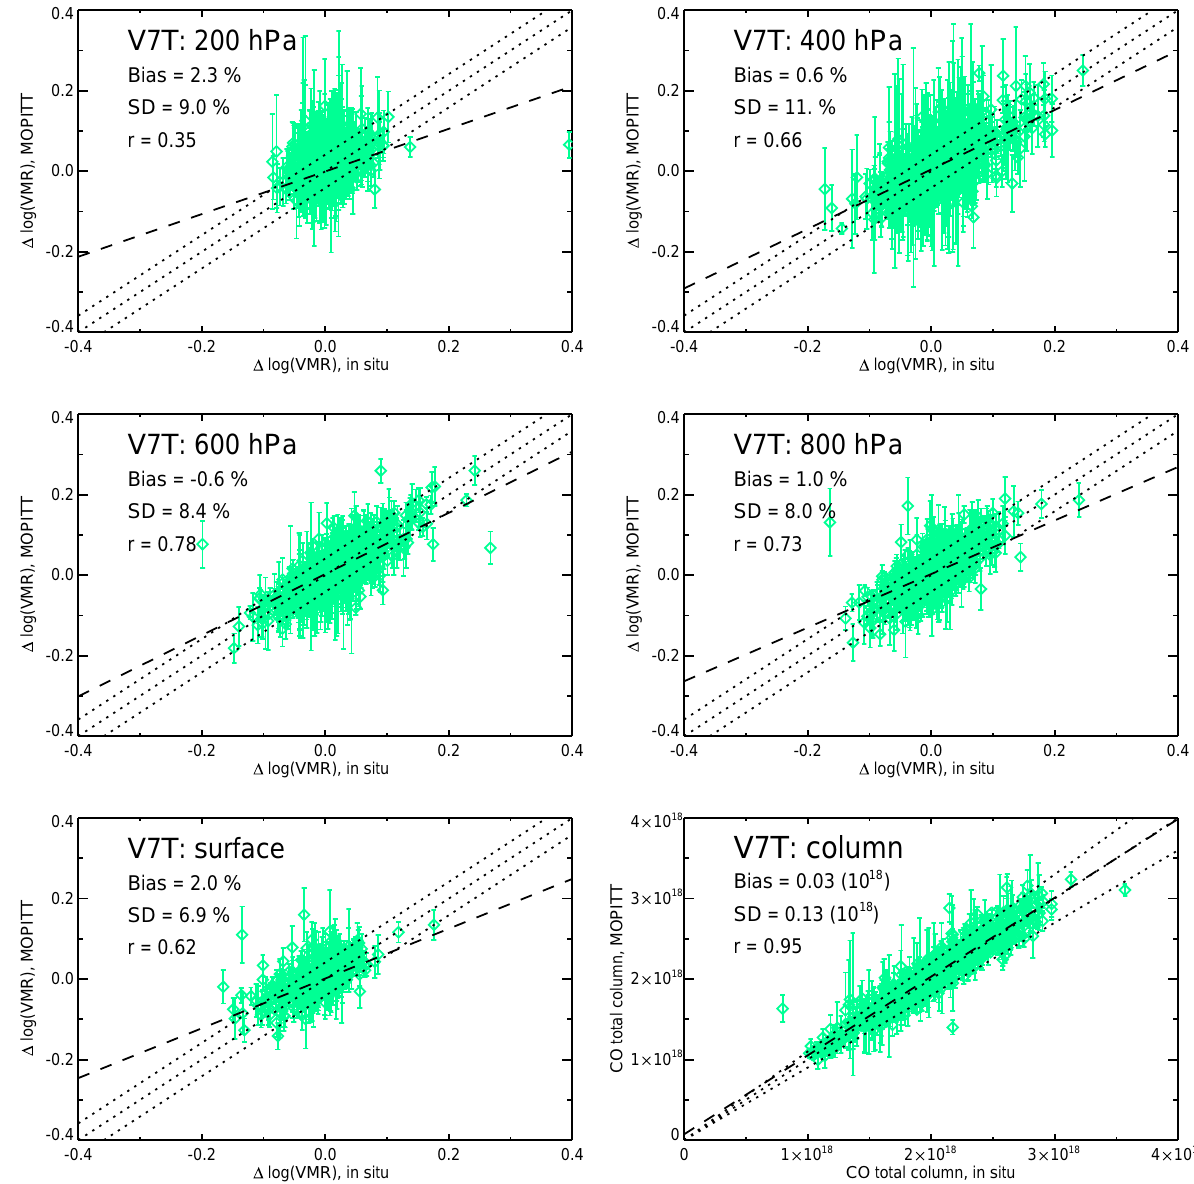
Figure 4. V7 TIR-only validation results based on the NOAA flask measurements. See caption to Fig.